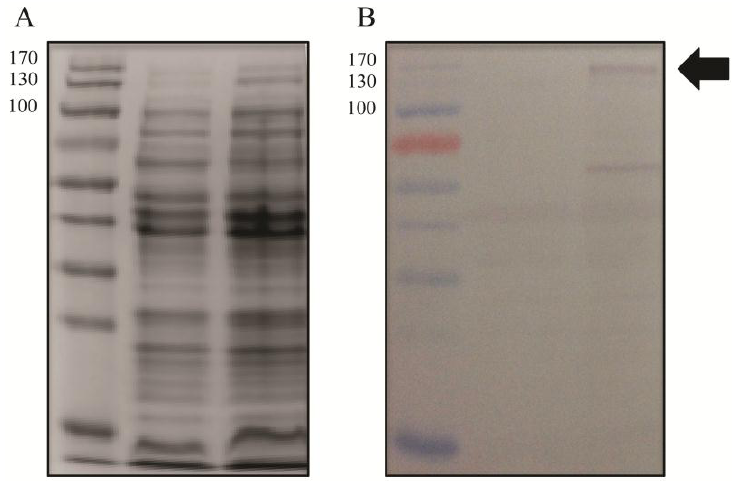
Figure 5. Gp047 can be expressed in C. jejuni 11168 cells. Gp047 was expressed in 11168 cells on the pCE 111-28 plasmid and cell lysates of wild type 11168 cells (lanes 1, 3) and 11168/pCE_ gp047 (lanes 2, 4) were subjected to SDS-PAGE stained with Coomassie; ( A ) or transferred to a Western blot and